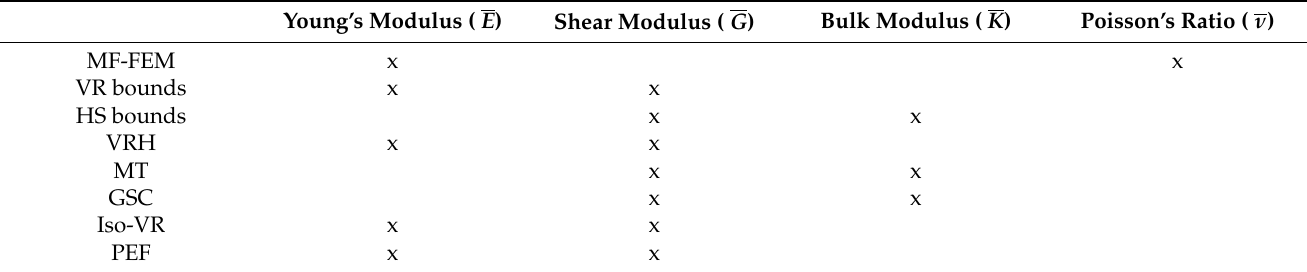
Table 4. Effective properties that are directly determined by MF-FEM and micromechanics models. Young’s Modulus ( E ) Shear Modulus ( G ) Bulk Modulus ( K ) Poisson’s Ratio ( ν